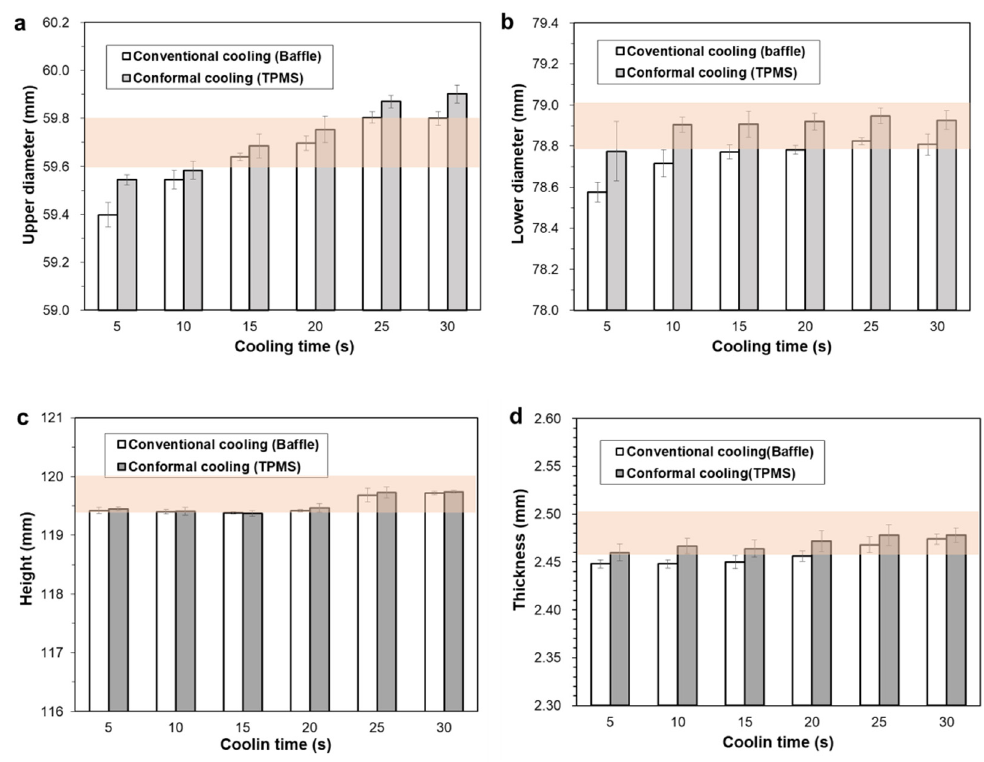
Figure 16. Comparison of dimensional accuracy of the molded parts according to the cooling time and method: ( a ) Upper diameter. ( b ) Lower diameter. ( c ) Cup height. ( d ) Wall thickness. In each graph, the shaded regions indicate the acceptable dimension ranges.